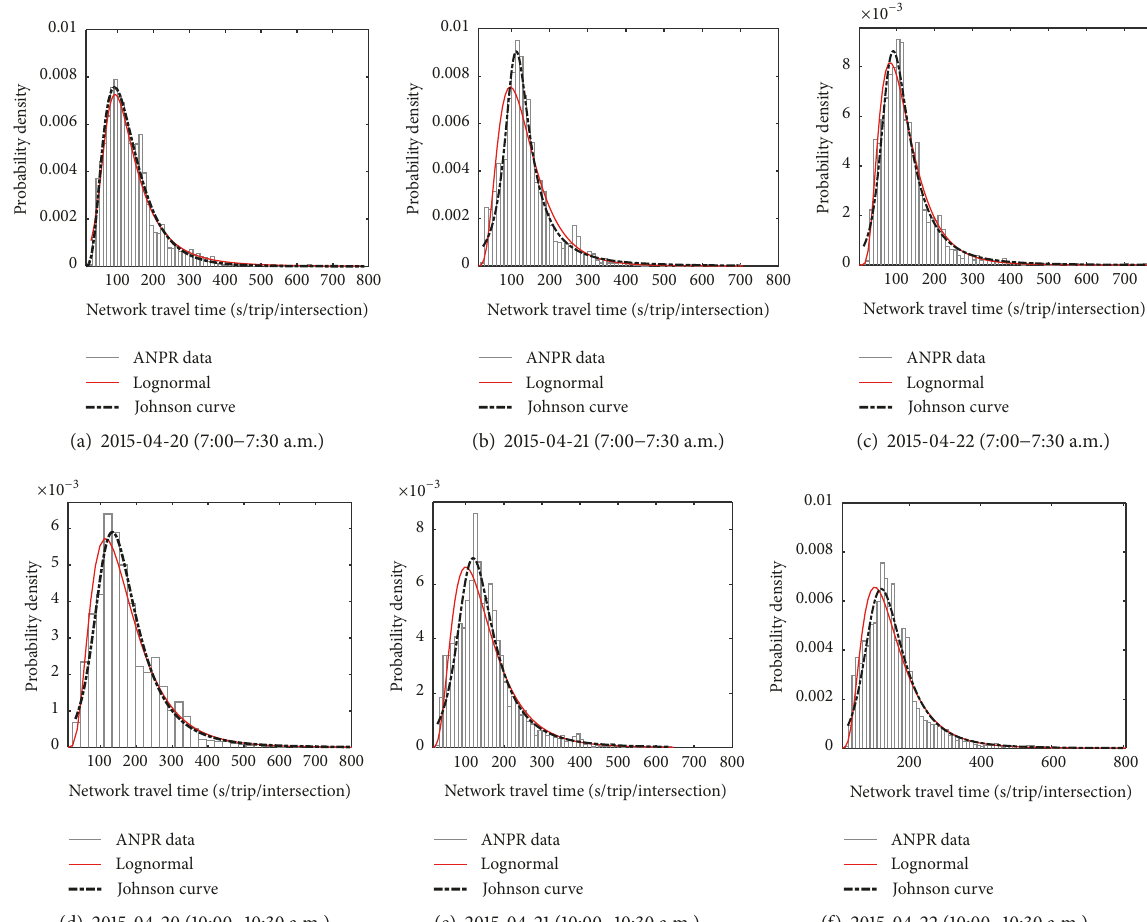
Figure3:NetworktraveltimeratedistributionfromANPRdataandfitteddensitycurvesatmorningpeak-hourperiod((a) − (c))andmorning off-peak period ((d) −